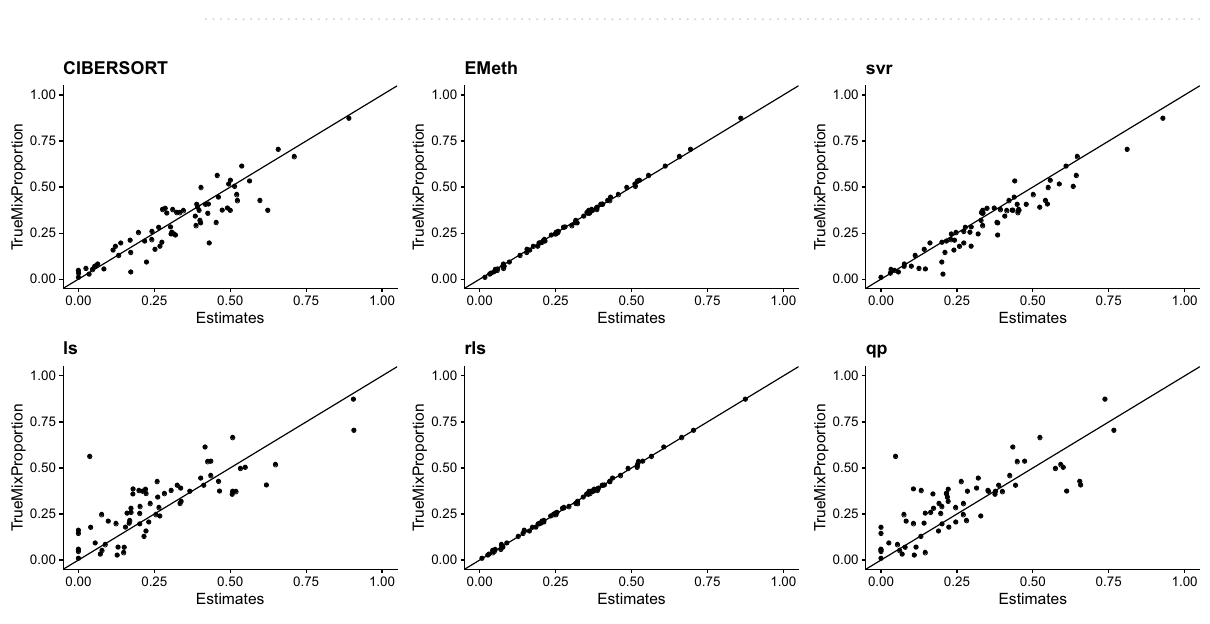
Figure 2. Evaluation of different methods using in silico mixtures. The upper row shows the correlation between the estimated proportions and the true proportions for each cell type and each method. The lower row displays the RMSE. The noise level parameter c were set as 5 to better demonstrate the difference across methods, and the conclusions are the same for other values of c . These plots were generated using R version 3.6.2 27 .